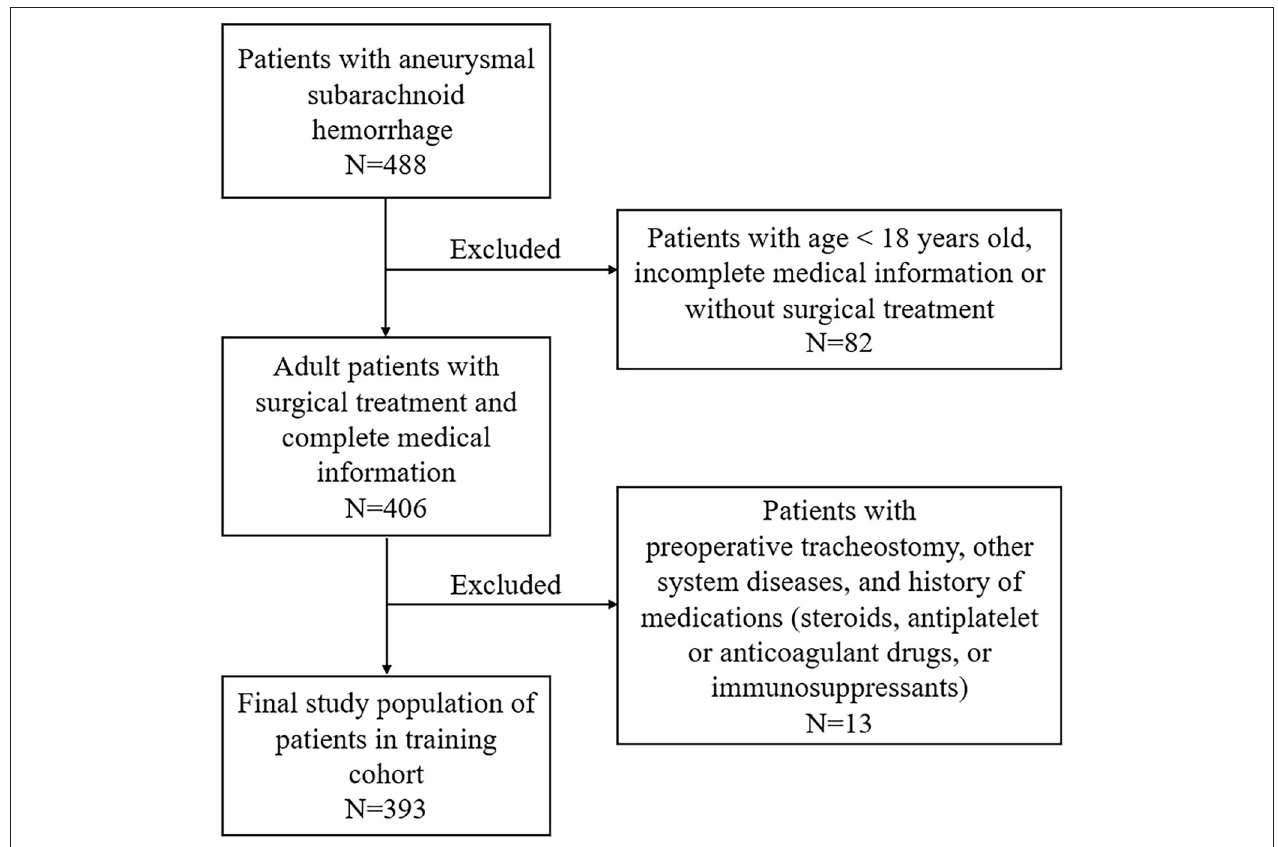
FIGURE 1 | Flowchart of aneurysmal subarachnoid hemorrhage patient selection in the training cohort.